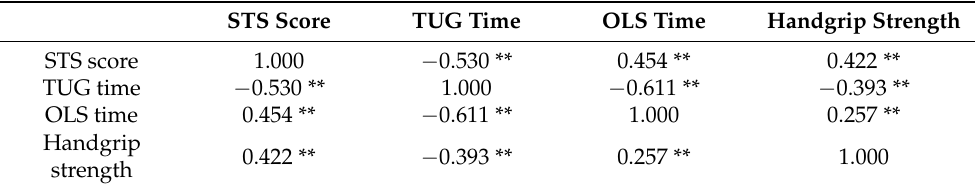
Table 4. Spearman’s rank correlation coefficients ( r s ) among the